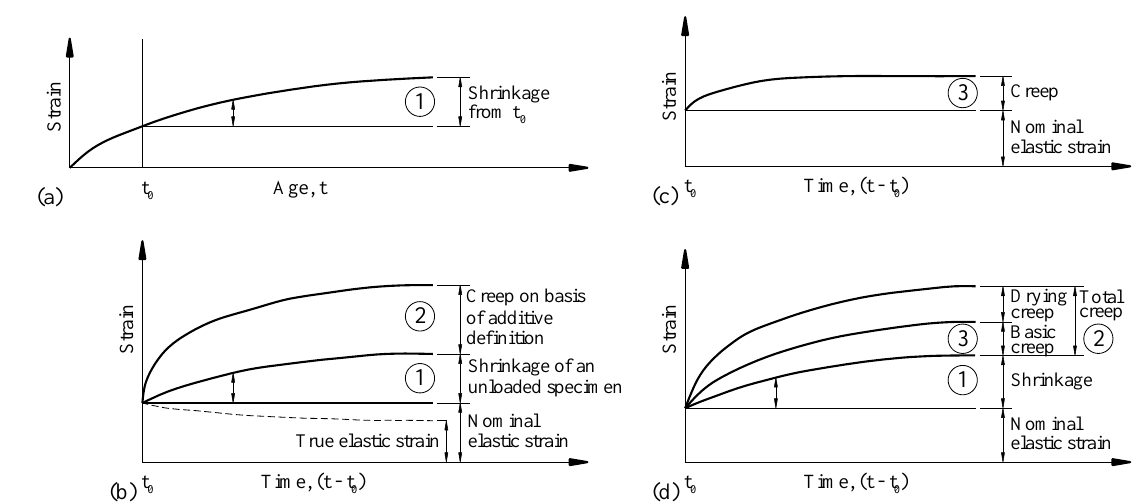
Figure 10. Definition of different strain of concrete: ( a ) shrinkage of an unloaded companion specimen, ( b ) change in strain of loaded and drying specimen, ( c ) creep of a loaded specimen in equilibrium with the ambient medium, ( d ) change in strain of a loaded and drying specimen [39].